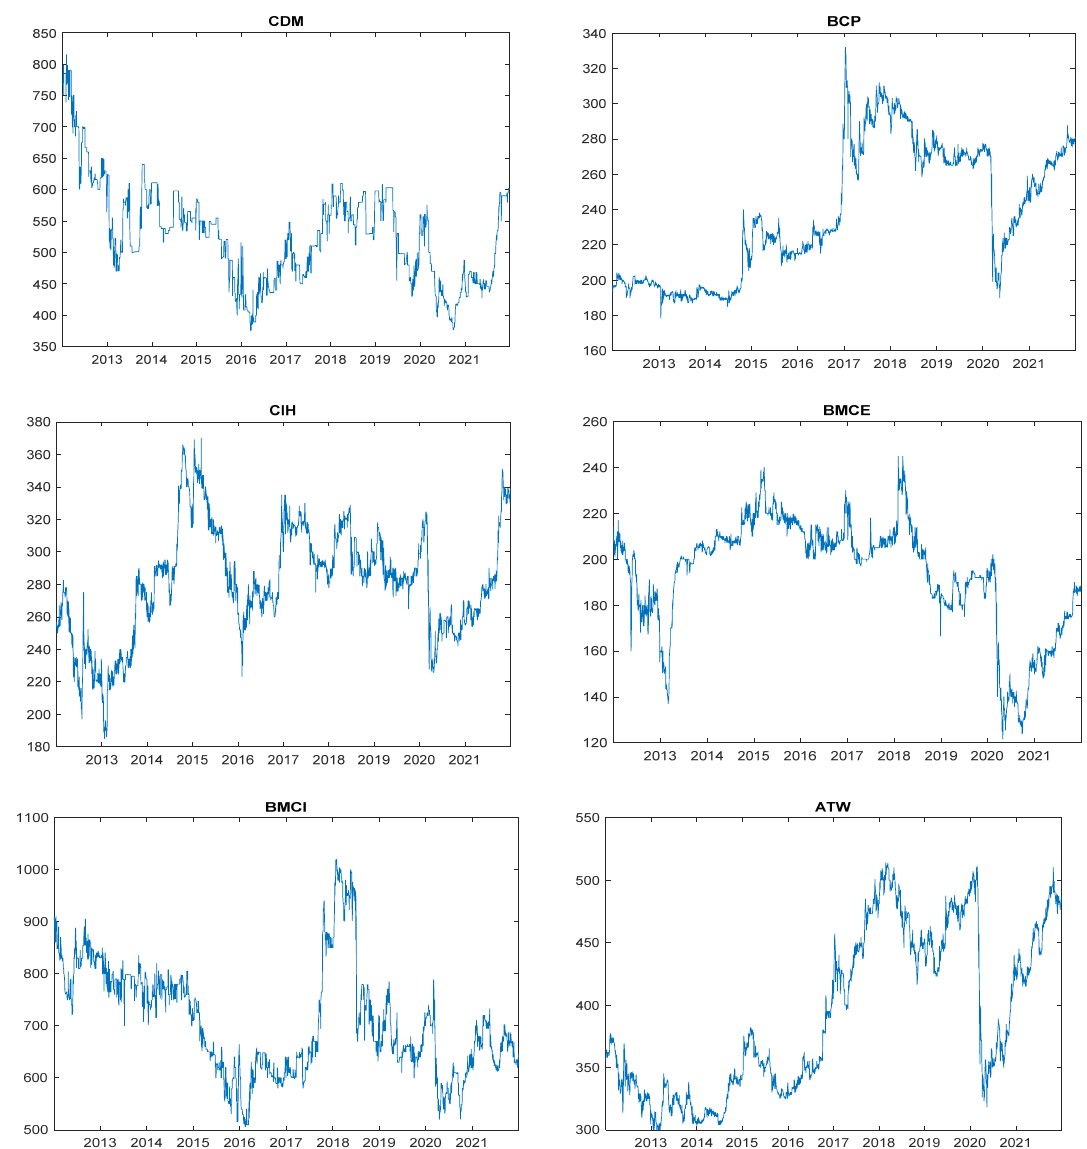
Figure 1. Evolution of the bank index price before and during the COVID-19 crisis.